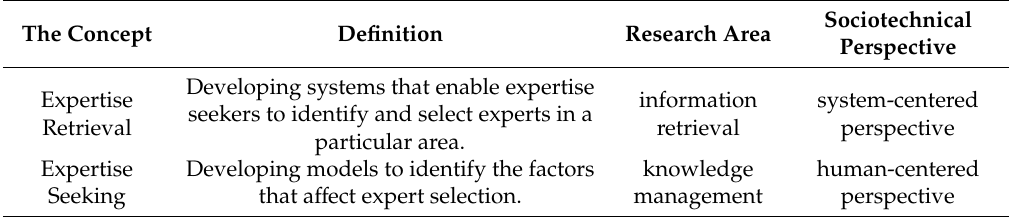
Table 5. The di ff erences between expertise retrieval and